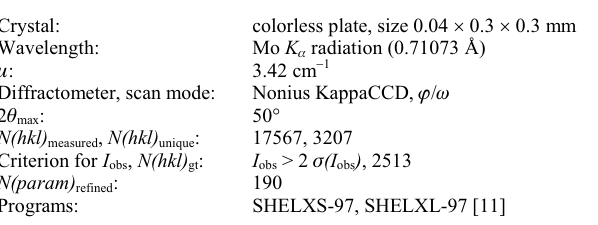
Table 1. Data collection and handling.